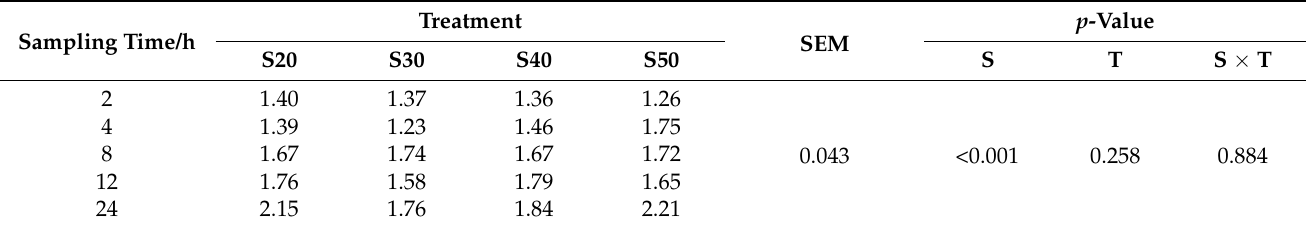
Table 4. The effect of substrate SP (% of CP) levels on MCP content at different sampling times in vitro (mg/mL).